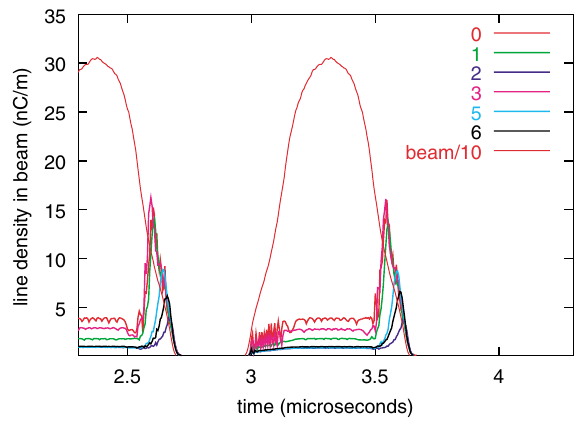
FIG. 7. (Color) Beam line density (AU) and electron current into the wall for the PSR with CSEC (blue) and POSINST (red). The beam line density, in arbitrary units, is shown to illustrate the relative timing.